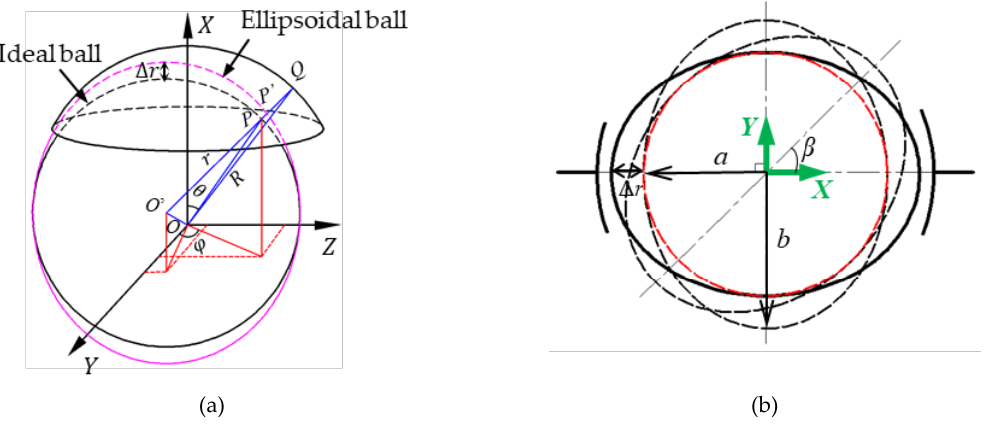
Figure 2. Sketch of the clearance between the ellipsoidal ball and the spherical plate. ( a ) 3D sketch, ( b ) 2D projection in the XOY plane as the ball rotates at various attitudes.